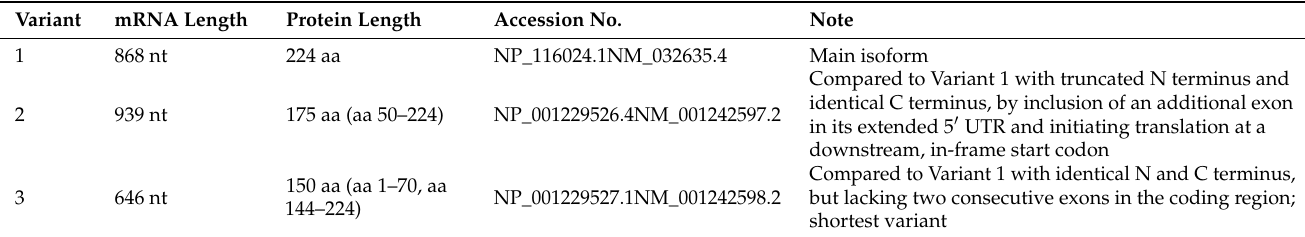
Table 1. TMEM147 variants in H. sapiens . Range information for Variants 2 and 3 indicates corresponding amino acids for Variant 1; nt—nucleotides; aa—amino